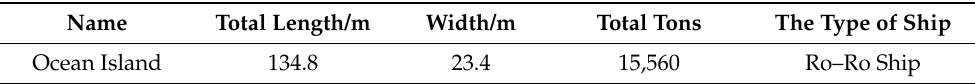
Figure 7. Location of the field experiment in Lushun port, China: ( a ) the geographic coordinate range of the field experiment; ( b ) the photo during the field experiment. Table 1. Parameters of the